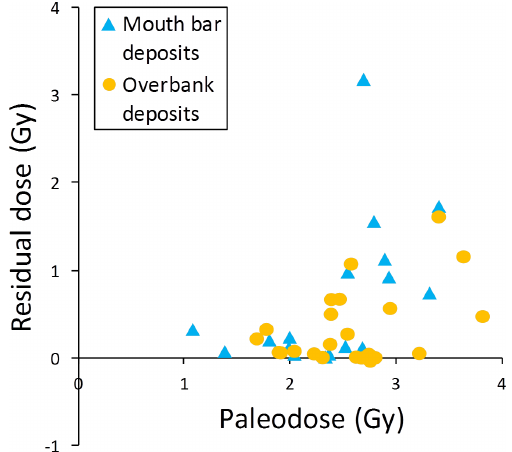
Figure 4. Residual doses calculated as D e , CAM minus D e , bootMAM versus the paleodose estimated as D e , bootMAM for mouth bar and overbank deposits of the Lafourche subdelta. Uncertainties, not shown here due to the high density of data points, are given in Ta- ble